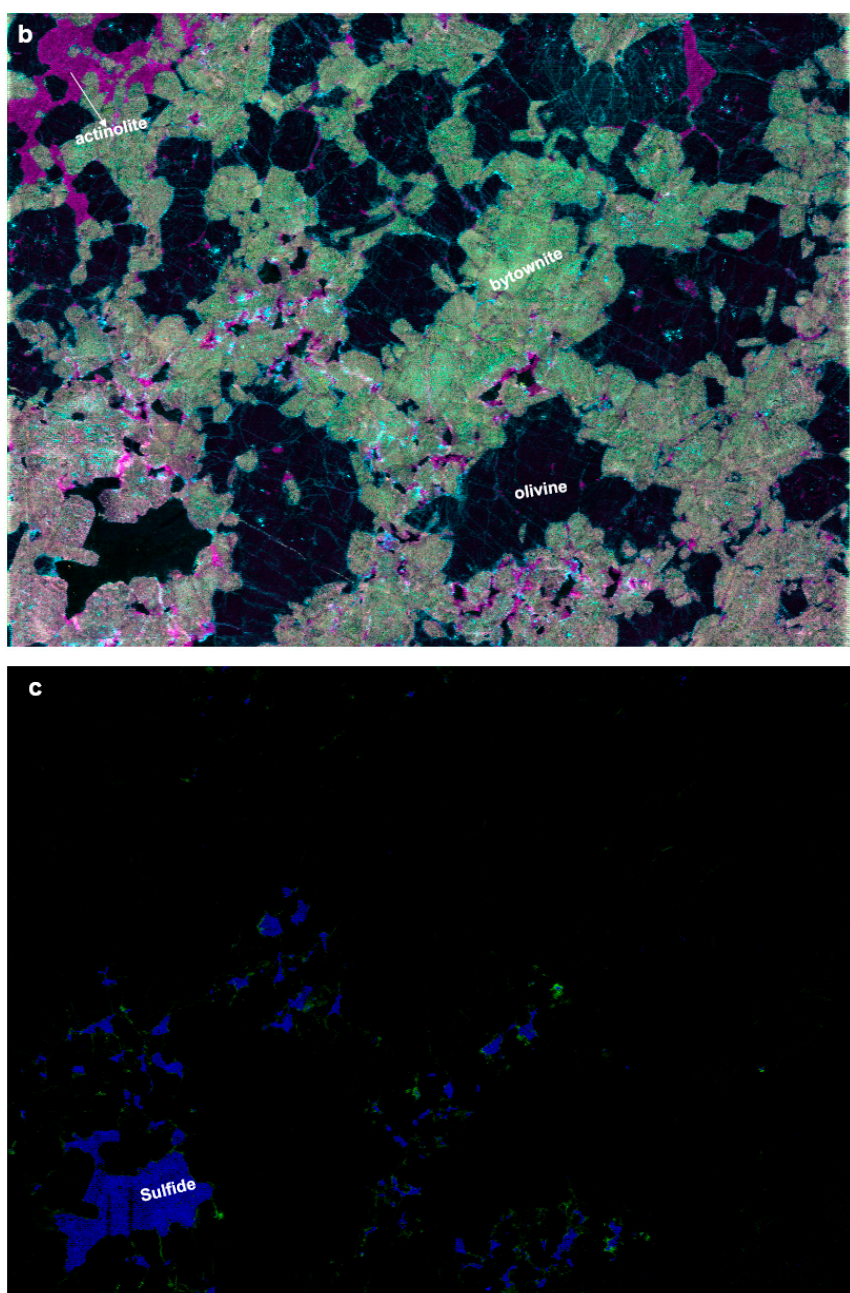
Figure 3. Mineral and elemental mapping of an area of 40 mm × 30 mm, composed of 801 × 601 pixels, on the surface of the rock of Figure 1 (outlined in the red perimeter). The spatial resolution (laser spot size and step size) is 50 µm. ( a ) Spatial distribution of Si (gray), Mg (blue), Cu (orange), Fe (green), Ni (cyan), Pd (magenta), and Pt (yellow). ( b ) Spatial distribution of K (cyan), Ca (Magenta), and Na (yellow). ( c ) Spatial distribution of S (blue) and Li (green).